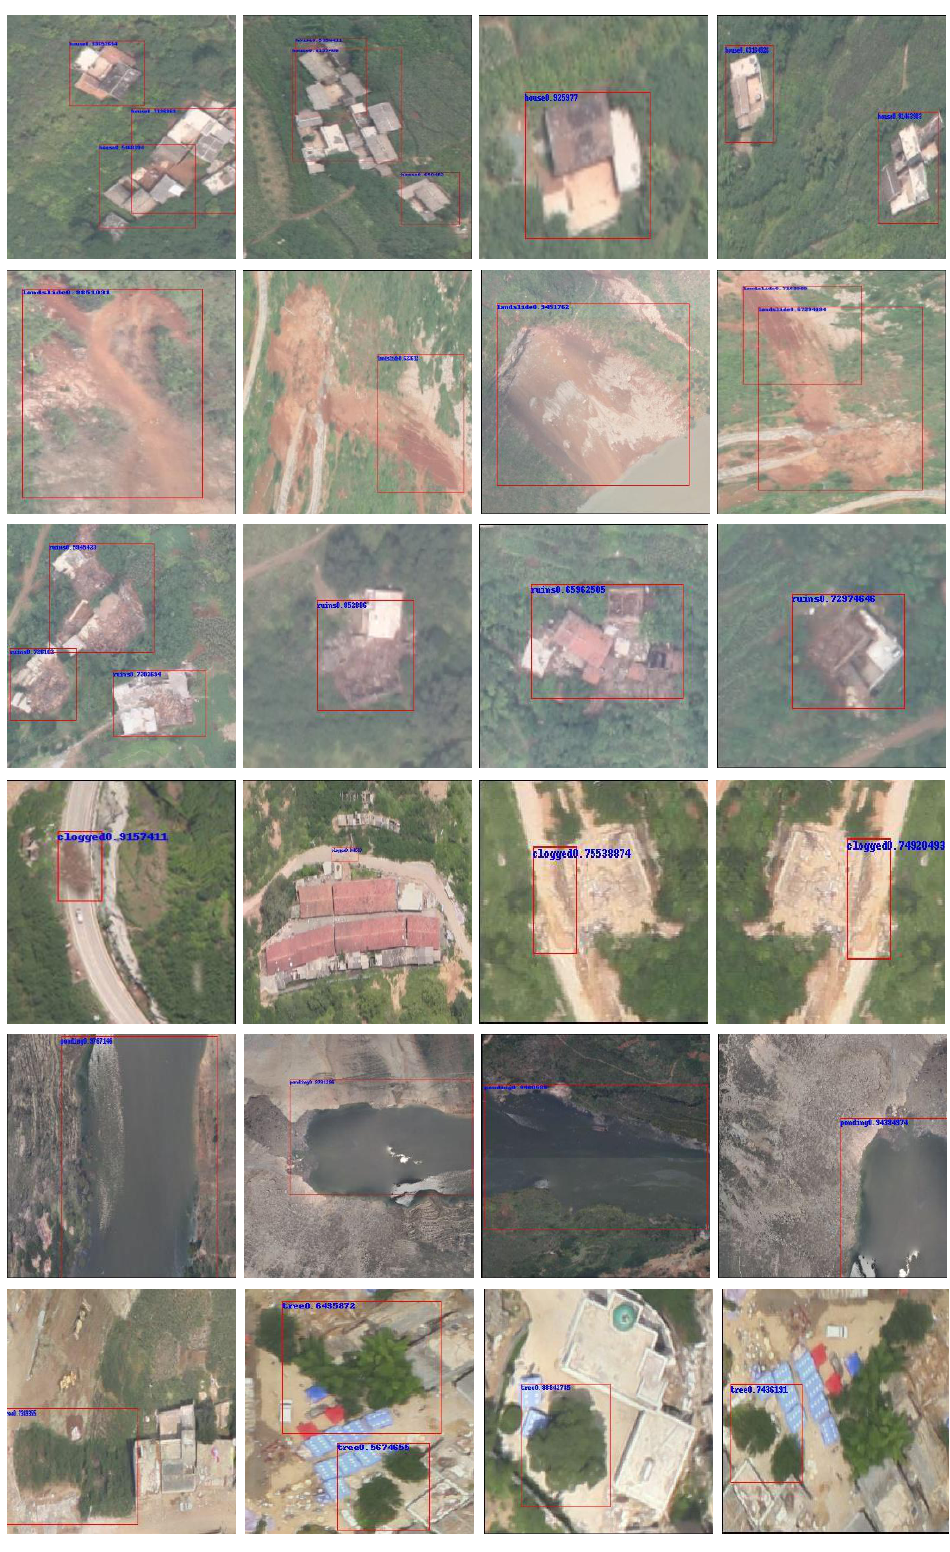
Figure 7. Examples of optimal PEMSR model test results. From top to bottom, scenes of houses, 452 landslide, ruins, clogged, ponding and trees are shown. 453